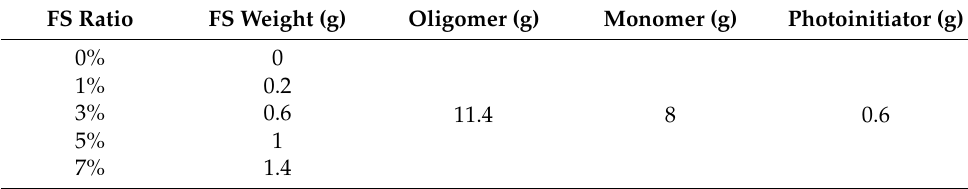
Table 1. Ink formulation in the experiments.